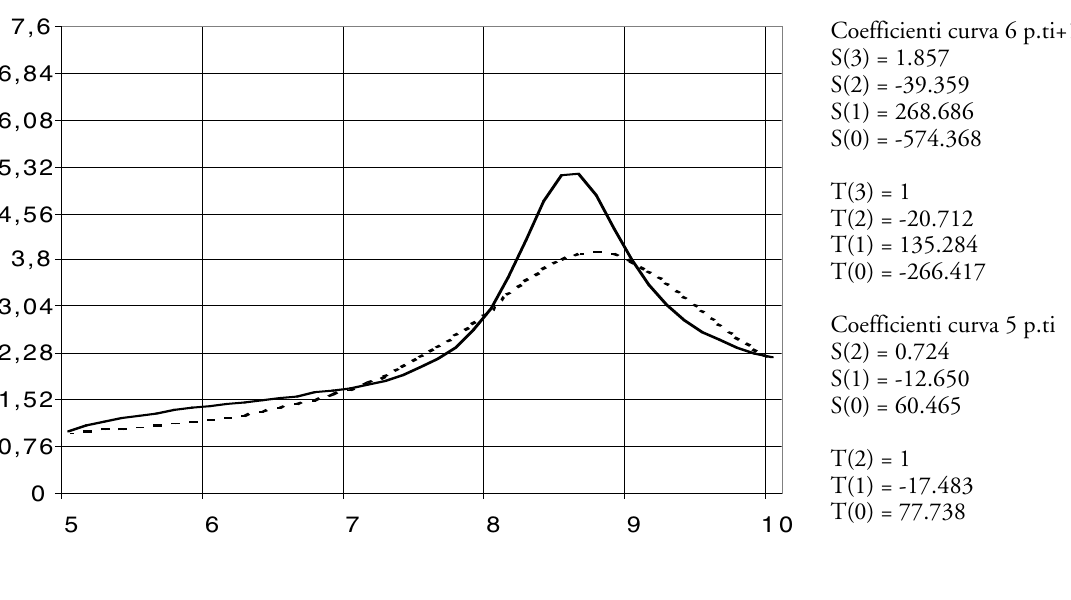
Figura 6 – Rilevazione di CO2 il 4-1-97 in MI1 La curva in linea continua passa per i 6 punti dati ma presenta discontinuità non eli- minabili.